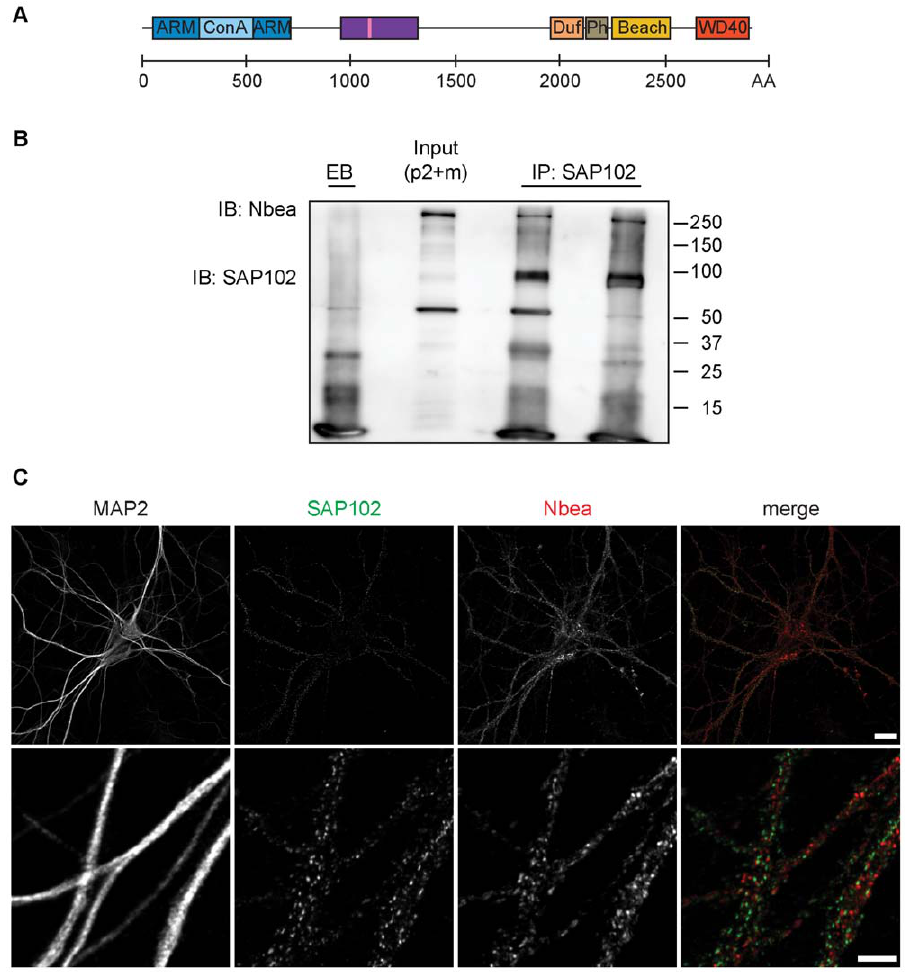
Figure 1. Nbea interacts with a fraction of SAP102 in vivo. (A) Schematic representation of mouse Nbea (NCBI Reference Sequence: NP_085098.1). The predicted armadillo (ARM) repeat-flanked Concavanalin A (Con A)-like lectin domain is localized at the N-terminus of the protein (blue). The region the Nbea antibody was raised against is depicted by the purple rectangle, encompassing also the PKA binding site (pink stripe). At the C-terminus the domain of unknown function 1088 (DUF; in orange), the Pleckstrin-Homology like domain (PH; in gray), the BEACH domain (yellow) and the WD40 repeats (red) are depicted. (B) Co-immunoprecipitation of SAP102 and Nbea from crude membrane with microsomes fraction (P2 + M) of P84 WT mice. Proteins were immunoprecipitated (IP) with two different a -SAP102 antibodies, i.e. a mouse monoclonal (NeuroMab clone N19/2; left lane) and a rabbit polyclonal one (GenScript; right lane), respectively. In the control condition non-coated, empty beads (EB) were used for the IP. The Input lane represents the crude membrane with microsomes fraction that was used for immunoprecipitation. Immuno-blotting (IB) was performed with a -Nbea and a -SAP102 antibody (NeuroMab clone N19/2). (C) Dendritic Nbea immunoreactivity shows limited overlap with SAP102. DIV14 WT hippocampal neurons (E18) fixed in methanol and stained for endogenous SAP102 (in green), endogenous Nbea (in red) and MAP2 (not shown in the merge). Top scale bar =20 m m, lower scale bar =5 m m.